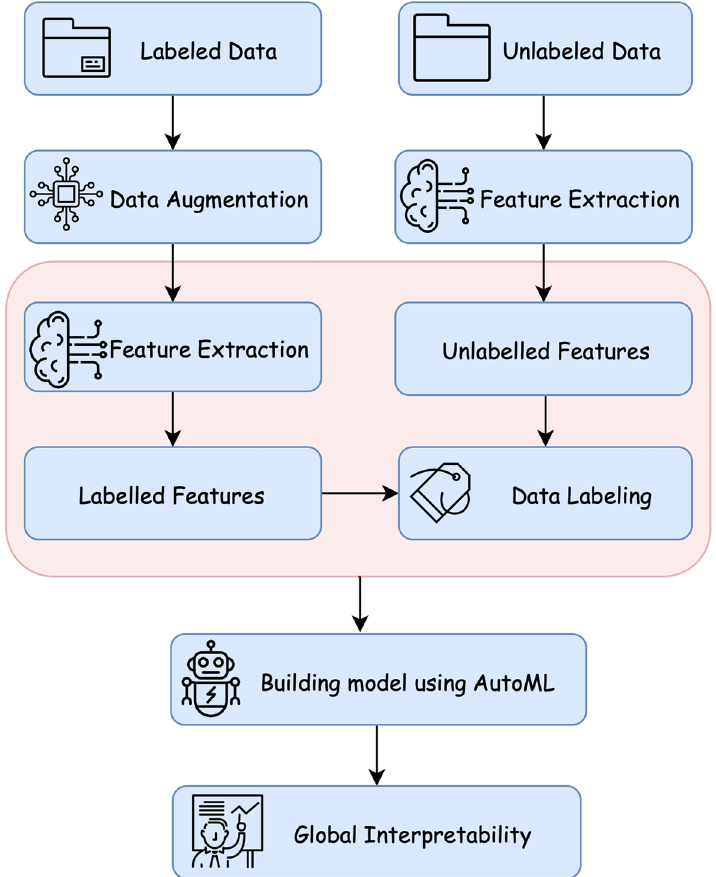
Figure 1. Flowchart of the proposed